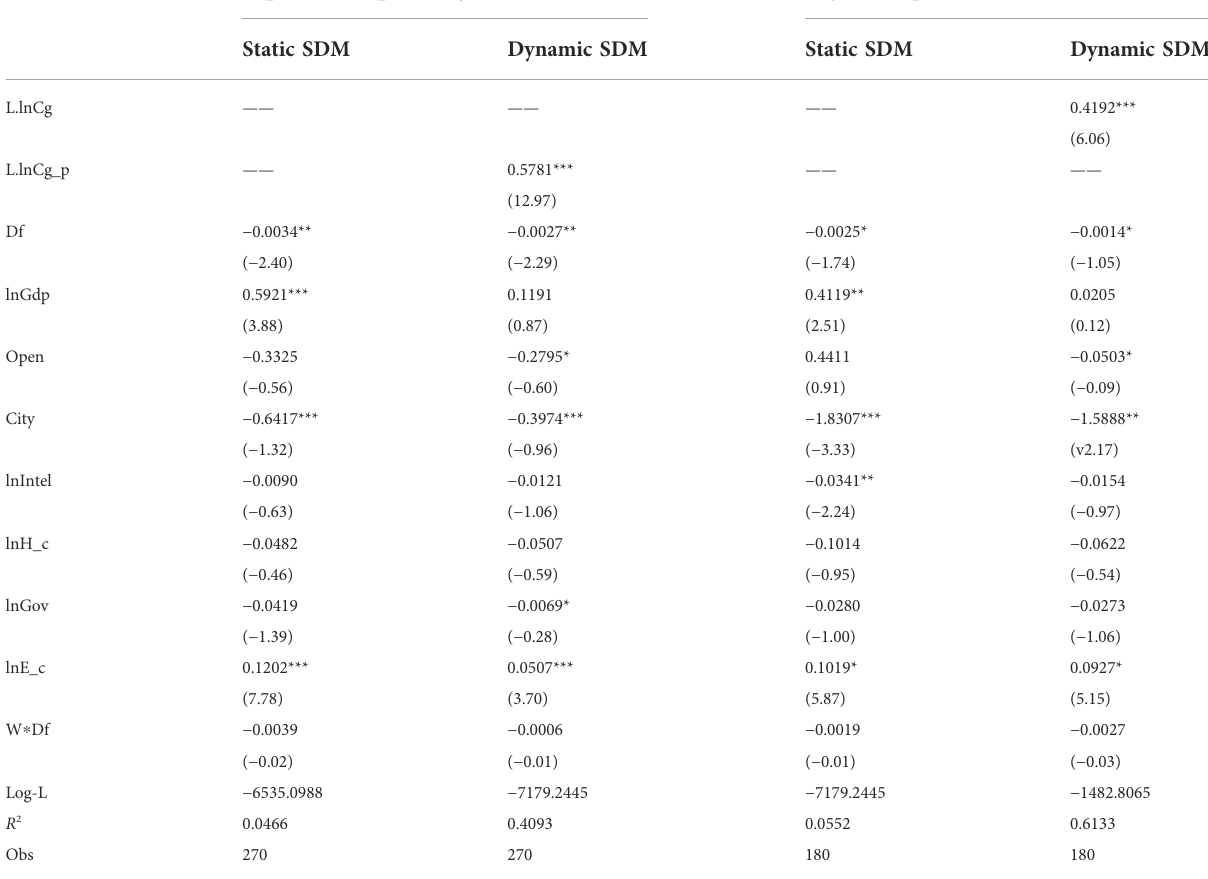
TABLE 5 Robustness